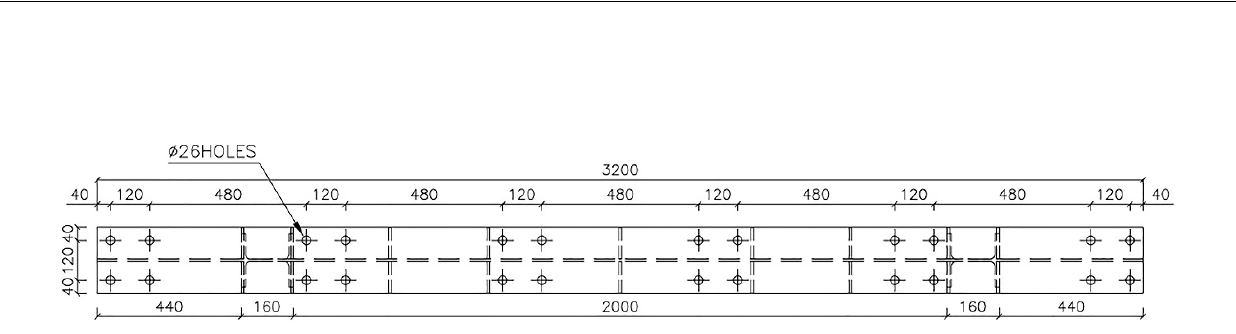
Figure 5. Details of connection of bottom beam to laboratory rigid steel floor.